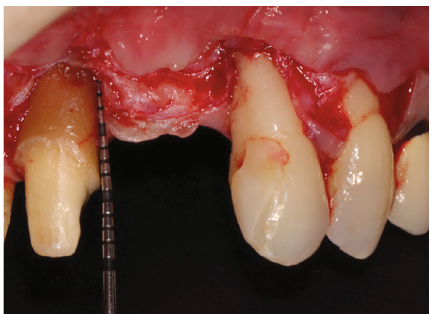
Figure 13: Probing depth after fl ap elevation.